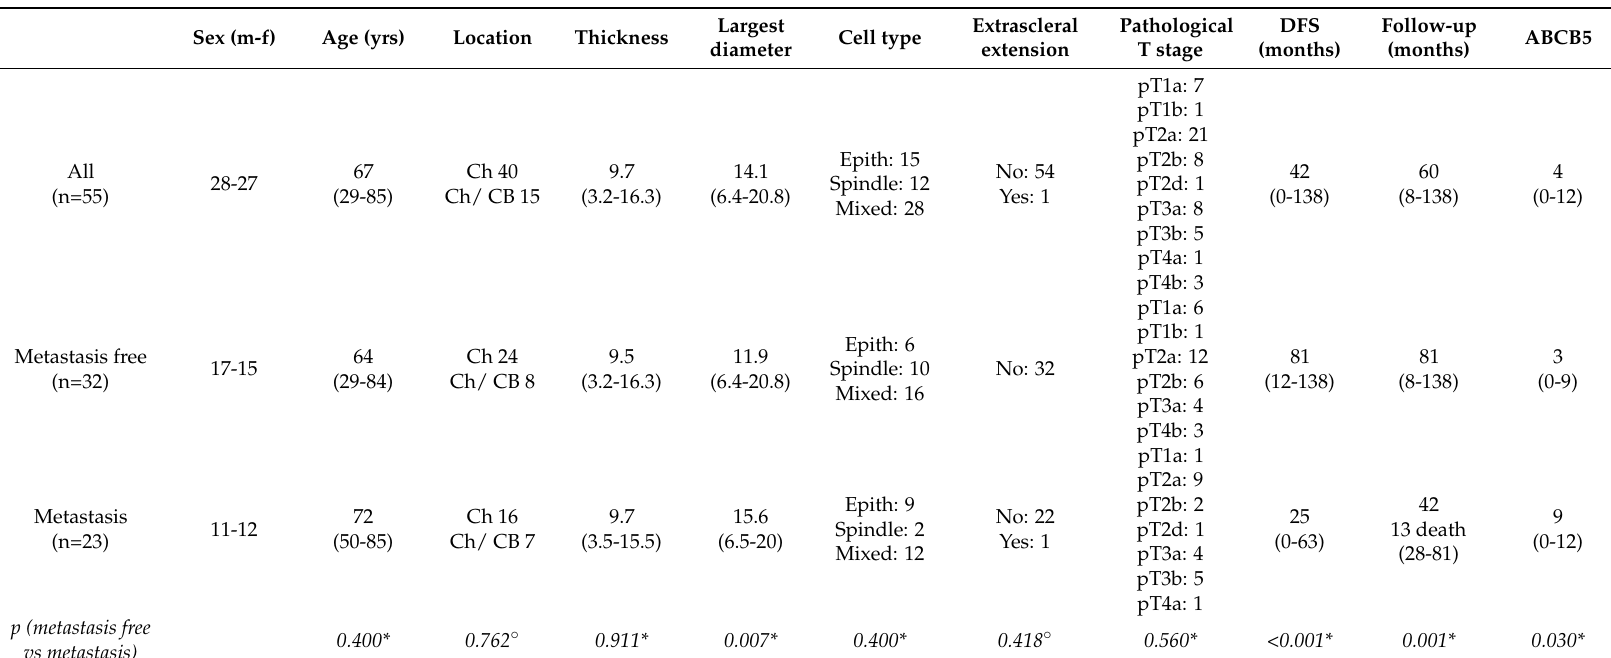
Table 3. Median (range) of demographics, tumour parameters, disease free time, follow-up, ABCB5 expression in primary uveal melanoma without and with systemic metastasis. Sex (m-f) Age (yrs) Location Thickness